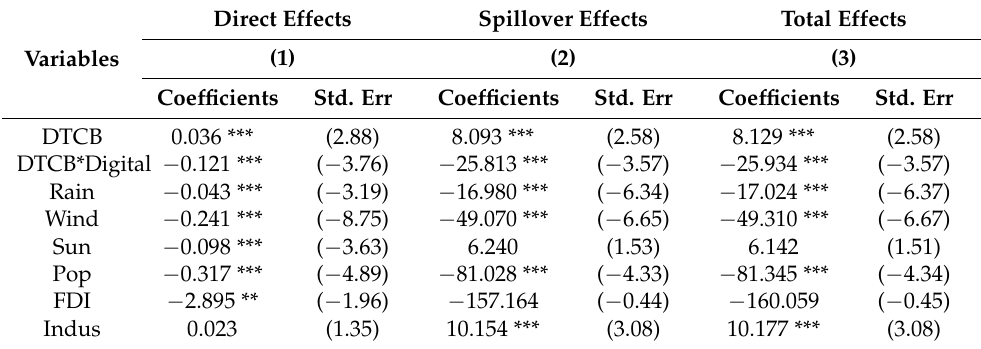
Table 10. Heterogeneity of Innovation